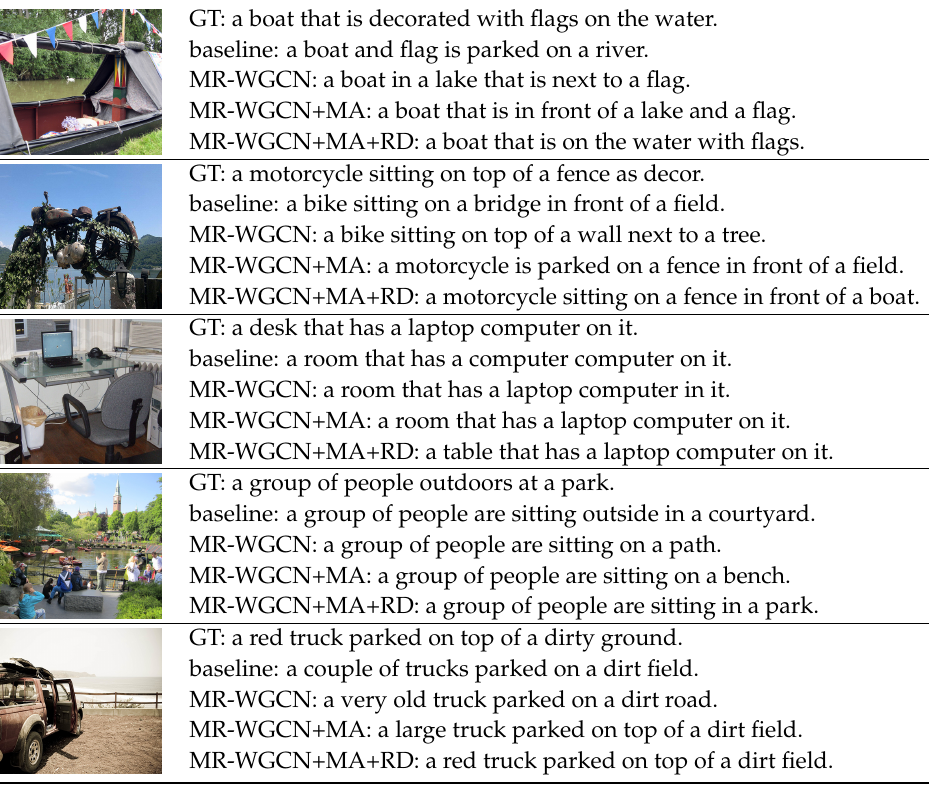
Figure 2. Examples of captions generated by the baseline model, various ablation models mentioned in the Section 4.4.1, as well as the corresponding ground truths